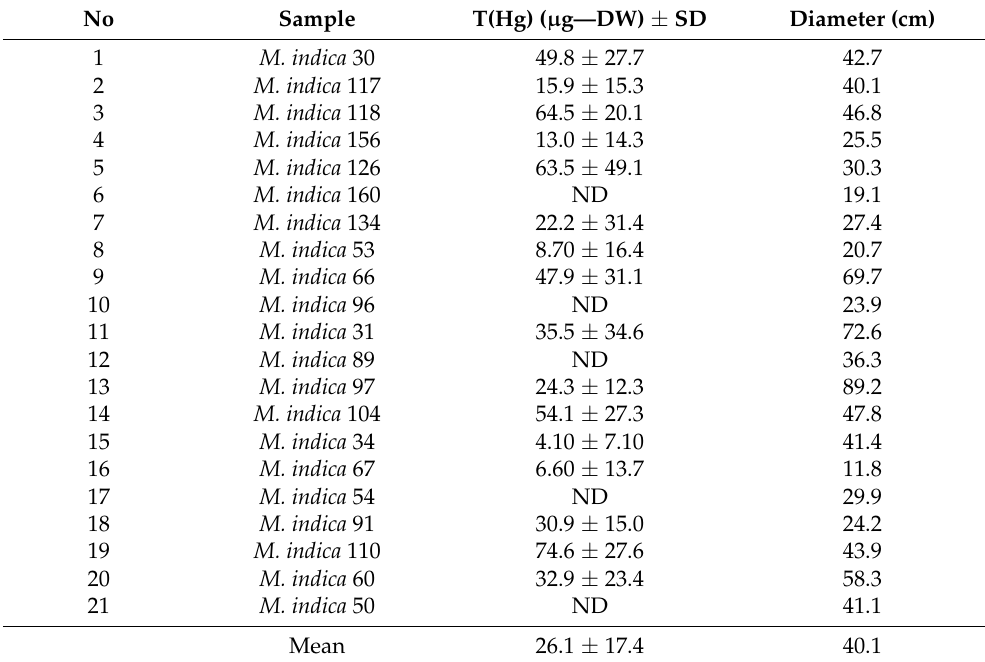
Table 1. Total weight of Hg (THg) in the bark and diameter of Mangifera indica .